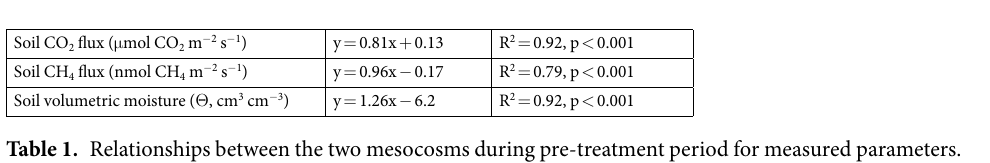
Figure 1. Soil mesocosms with auto-samplers and watering systems (upper panel, with inset photo showing full mesocosms); detail of soaker hose used for rainfall simulation (lower panel). The fan beside the soaker hose ensured air mixing within the chamber headspace during flux measurements.